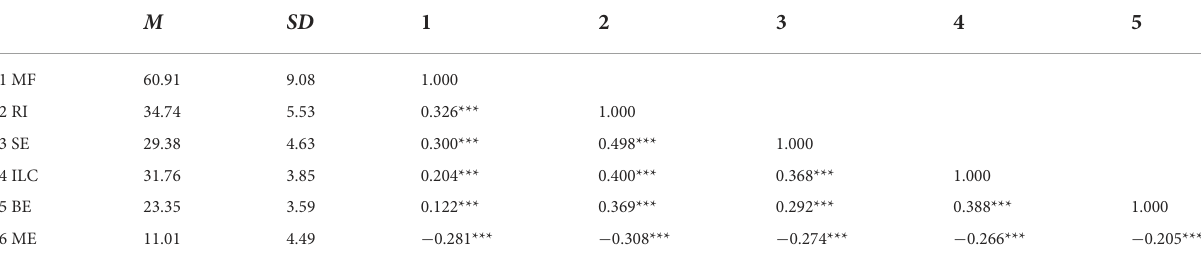
TABLE 1 Descriptive statistics and correlations for major measures.